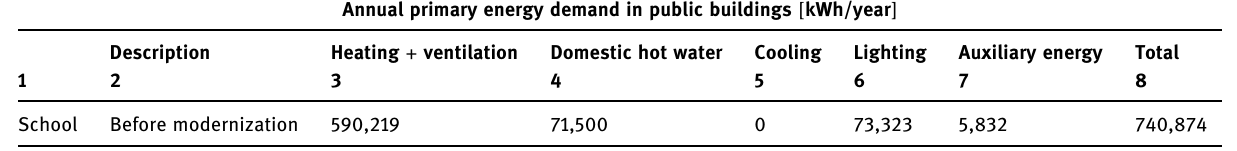
Table 1: Energy demand of the